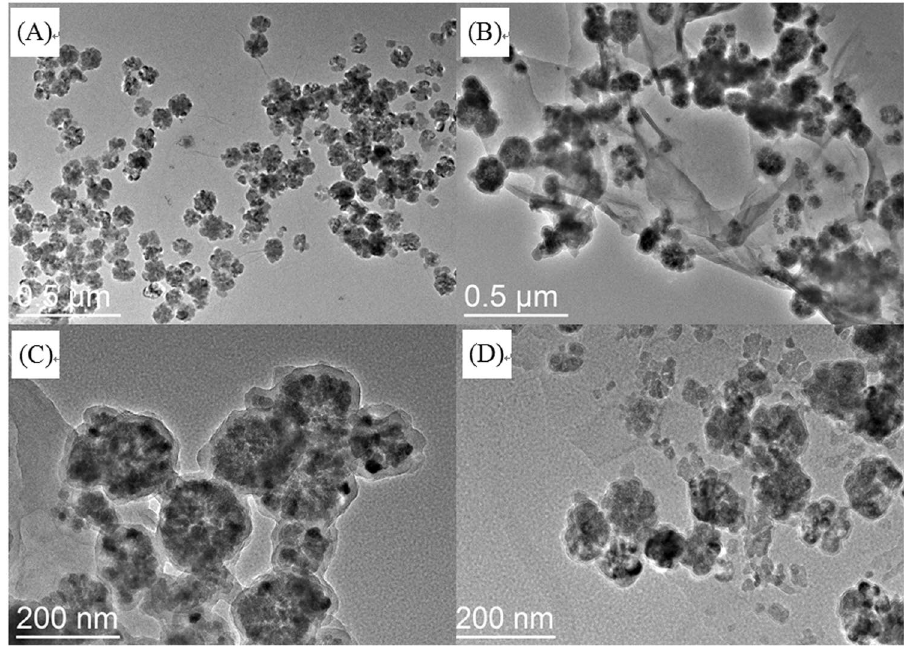
Figure 2. TEM images of GO/Fe 3 O 4 ( A ), PDA@GO/Fe 3 O 4 ( B ), PDA@GO/Fe 3 O 4 ( C ), and NPDA@GO/Fe 3 O 4 ( D